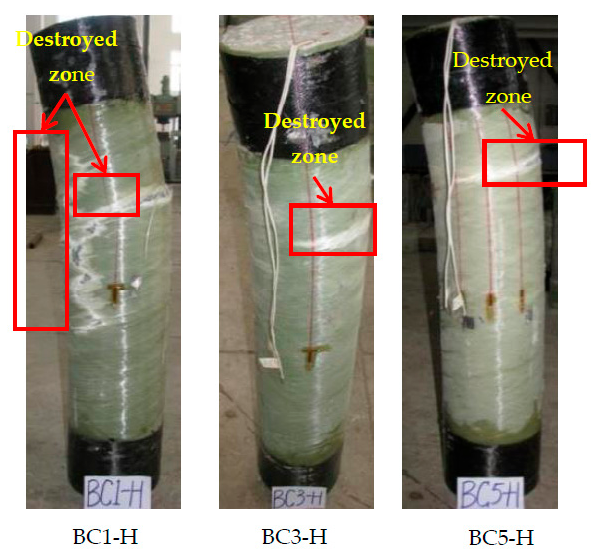
Figure 7. Typical failure modes for the eccentrically loaded specimens.